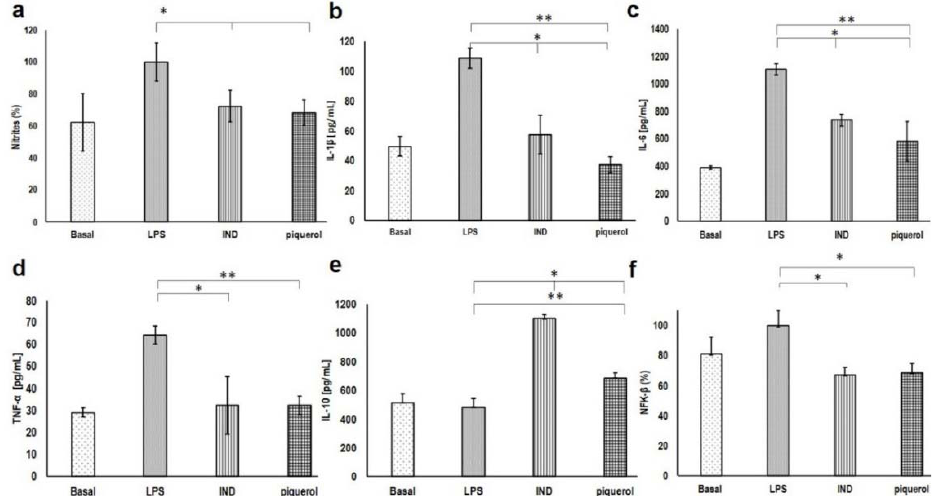
Figure 2. Activity of piquerol and IND at 150.51 µ M and 47.8 µ M, respectively, in J774A.1 macrophages stimulated with LPS on the production of ( a ) NO; ( b ) IL-1 β ; ( c ) IL-6; ( d ) TNF- α ; ( e ) IL-10; and ( f ) NF- κ B. The graph represents the mean ± standard deviation of three independent experiments ( n = 6). ** p < 0.01 and * p < 0.05 statistically significant difference compared ( a – d , f ) with LPS, and IL-10 ( e ) piquerol group was compared to IND group.